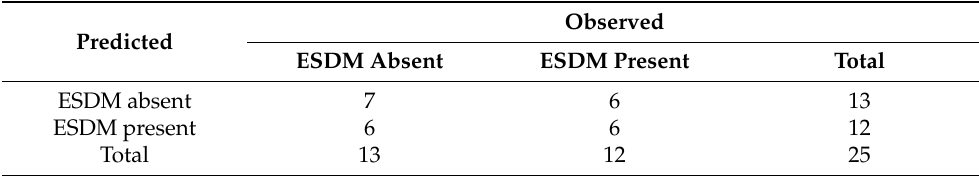
Table 2. Confusion matrix comparing observed occurrence of eastern spruce dwarf mistletoe (ESDM) with that predicted by Hanks et al. (2011).